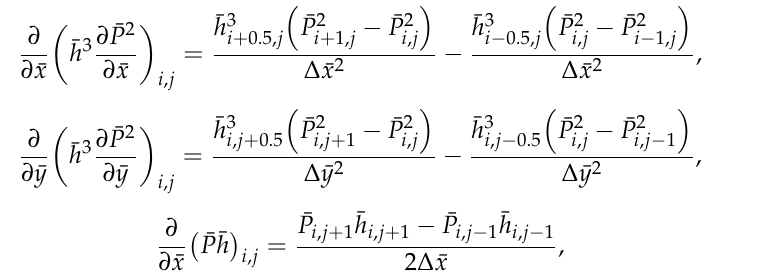
Figure 3. Five-point difference